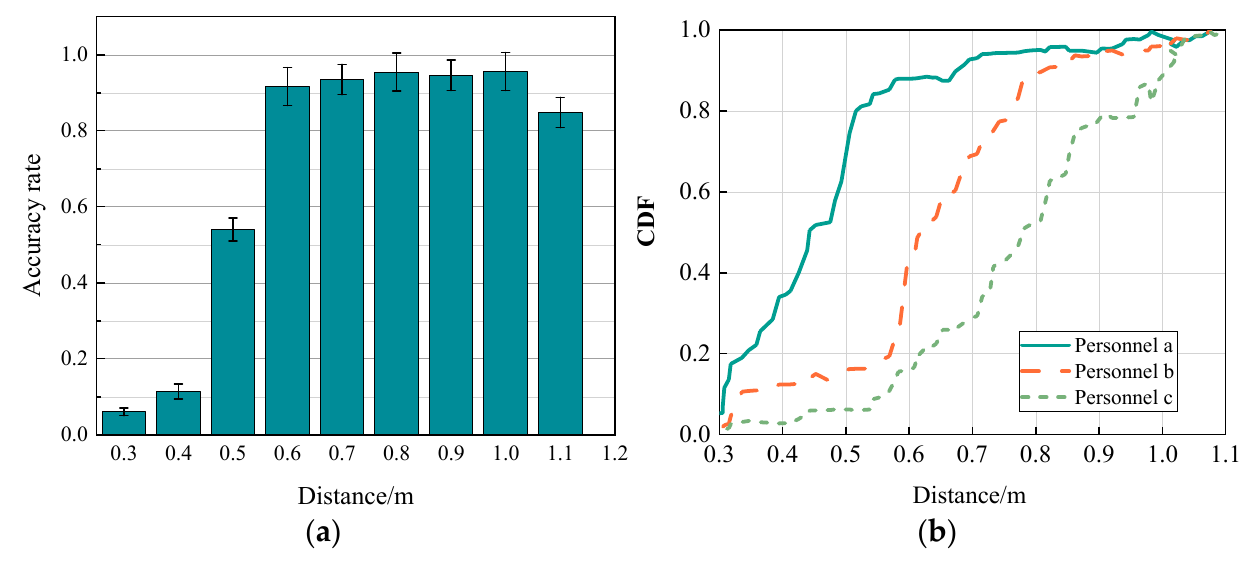
Figure 10. ( a ) Recognition effect at different distances; ( b ) cross-person identification CDF chart .